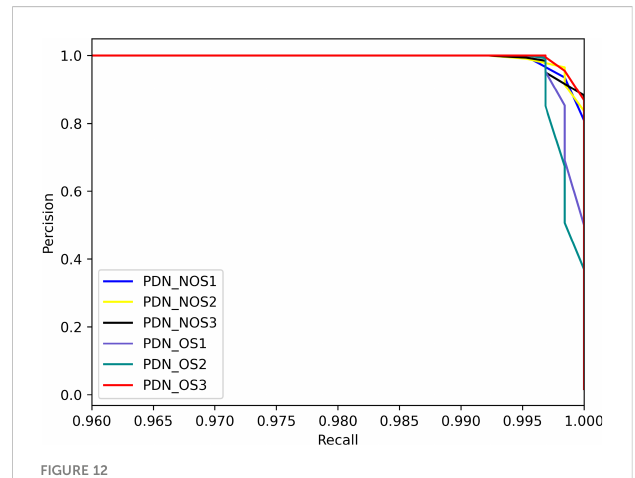
FIGURE 12 Precision-recall curve under different con fi dence